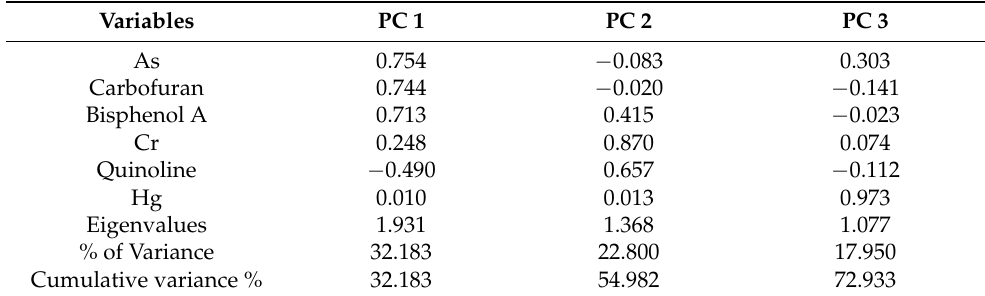
Table 2. Principal component analysis of three components with the corresponding loading of target compounds of the study